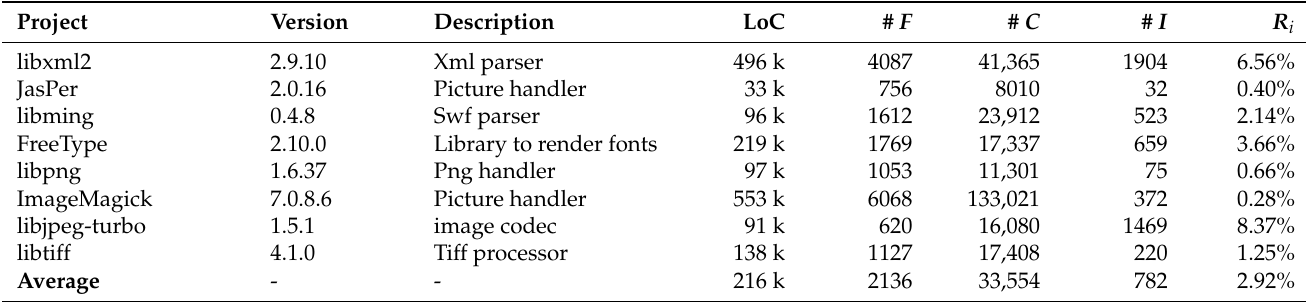
Table 1. The distribution of indirect jumps in real